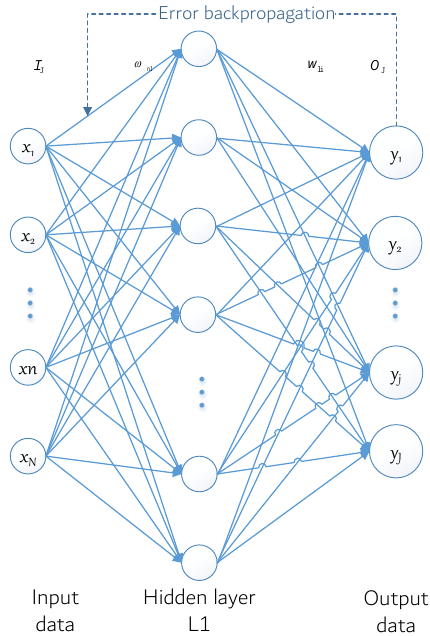
Figure 4. BP neural network